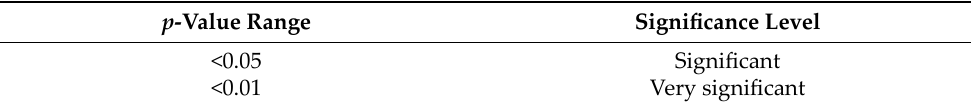
Table 2. p ‑value